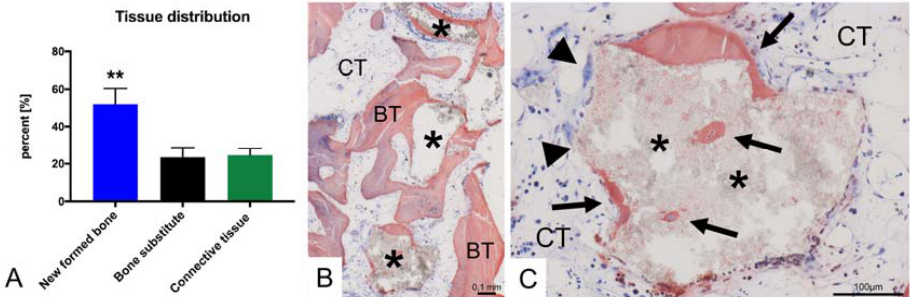
Figure 5. Results of the histological and histomorphometrical analyses. ( A ) Tissue distribution six months post-OP (** p > 0.01); ( B ) Integration of the FDBA material (asterisks) surrounded by vascularized connective tissue (CT) and new formed bone (BT); ( C ) Both the material ‐ mediated bone growth (arrows) in combination with the multinucleated giant cells (arrowheads) resemble the ongoing remodeling processes.